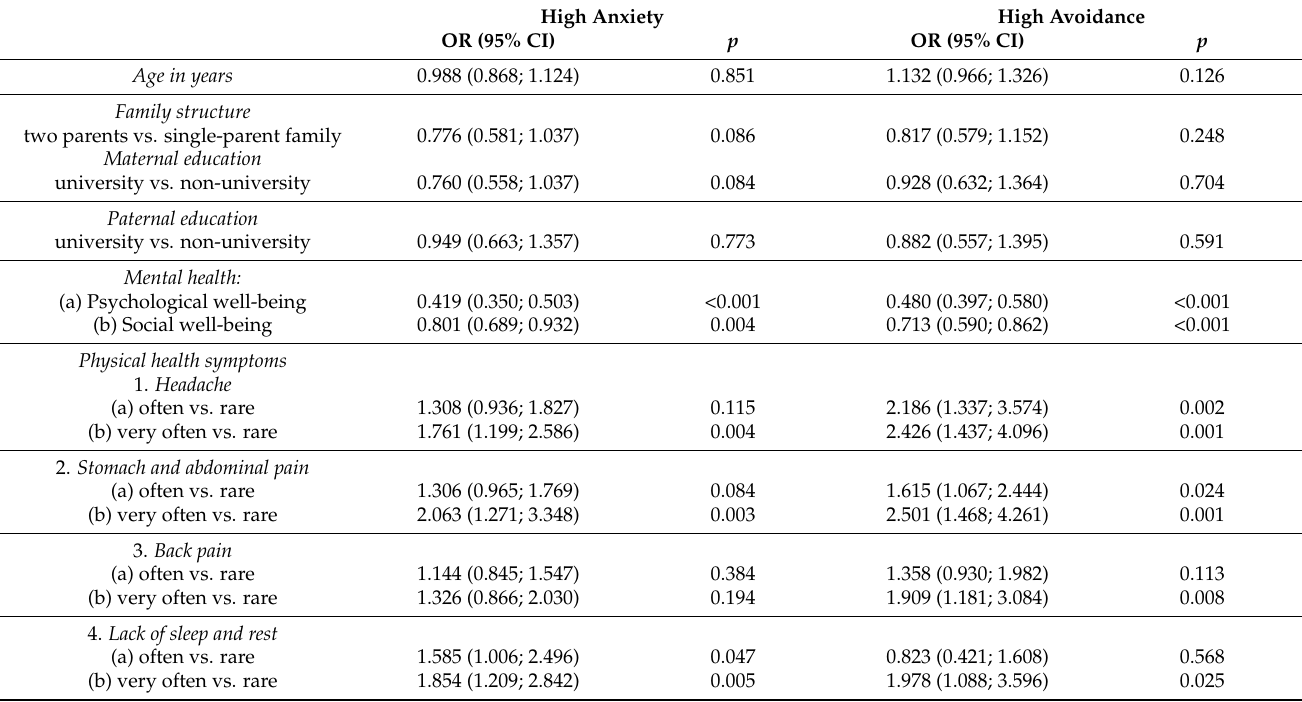
Table 3. Univariate logistic regression: the ratio of females’ odds ratio to be high on SA (anxiety and avoidance groups). High